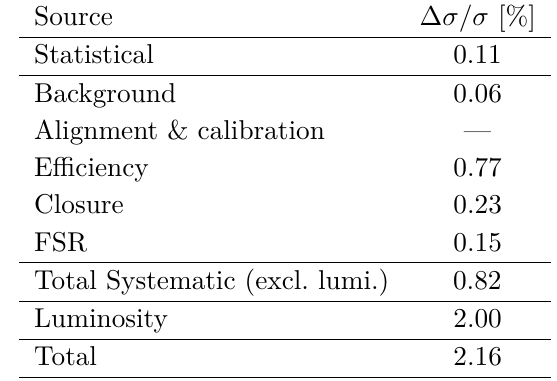
Table 1 . Relative uncertainty for the integrated Z → µ + µ − cross-section measurement. The total uncertainty is the quadratic sum of uncertainties from statistical, systematic and luminosity